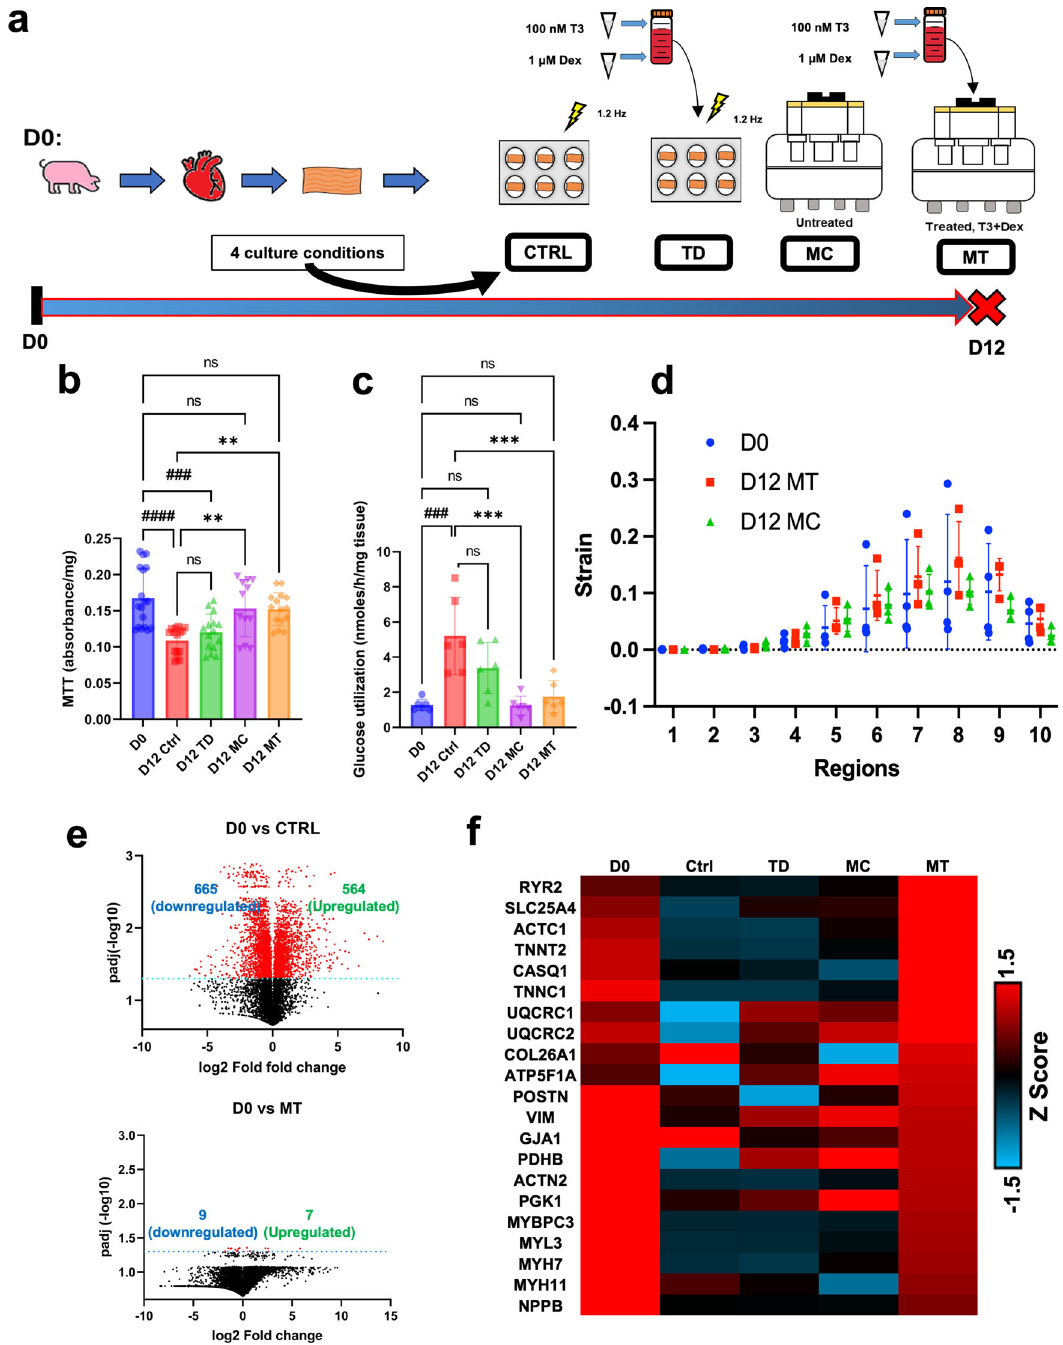
Fig. 4 Combining mechanical and humoral stimulation (MT condition) preserve the heart slices for 12 days. a Schematic representation of the experimental design depicting the four culture conditions that were used to assess the effect of combining mechanical stimulation and T3/Dex addition to the culture media over the course of 12 days. b Bar graph shows quanti fi cation of viability 12 days post culture in all 4 culture conditions (Ctrl, TD, MC, and MT) compared to fresh heart slices (D0) ( n = 18 (D0), 15 (D12 Ctrl, D12 TD and D12 MT), 12 (D12 MC) slices/group from different pigs, one-way ANOVA test is performed; #### p < 0.0001, ### p < 0.001 compared to D0 and ** p < 0.01 compared to D12 Ctrl). c Bar graph shows the quanti fi cation of glucose fl ux 12 days post culture in all 4 culture conditions (Ctrl, TD, MC, and MT) compared to fresh heart slices (D0) ( n = 6 slices/group from different pigs, one-way ANOVA test is performed; ### p < 0.001, compared to D0 and *** p < 0.001 compared to D12 Ctrl). d Strain analysis plot for fresh (blue), day 12 MC (green), and day 12 MT (red) tissue across the ten regional points of the tissue slice ( n = 4 slices/group, one-way ANOVA test is performed; no signi fi cant difference between the groups). e Volcano plots showing the differentially expressed genes in fresh heart slices (D0) compared to heart slices cultured under static conditions (Ctrl) or MT conditions (MT) for 10 – 12 days. f Heatmap for the sarcomeric genes for heart slices cultured under each culture condition. Error bars are representative of the Mean± SD.